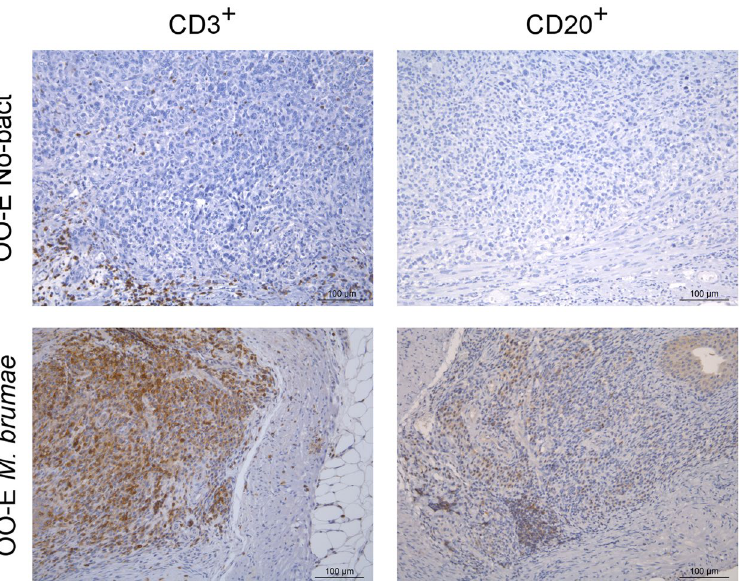
Figure 2. Representative histological images of bladder sections stained with two immunological markers. Bladders from the OO-E No-bact group (top) and from the OO-E live M. brumae group (bottom). Sections were stained with a CD3 marker (left column) and CD20 marker (right column). Scale bar, 100 µ